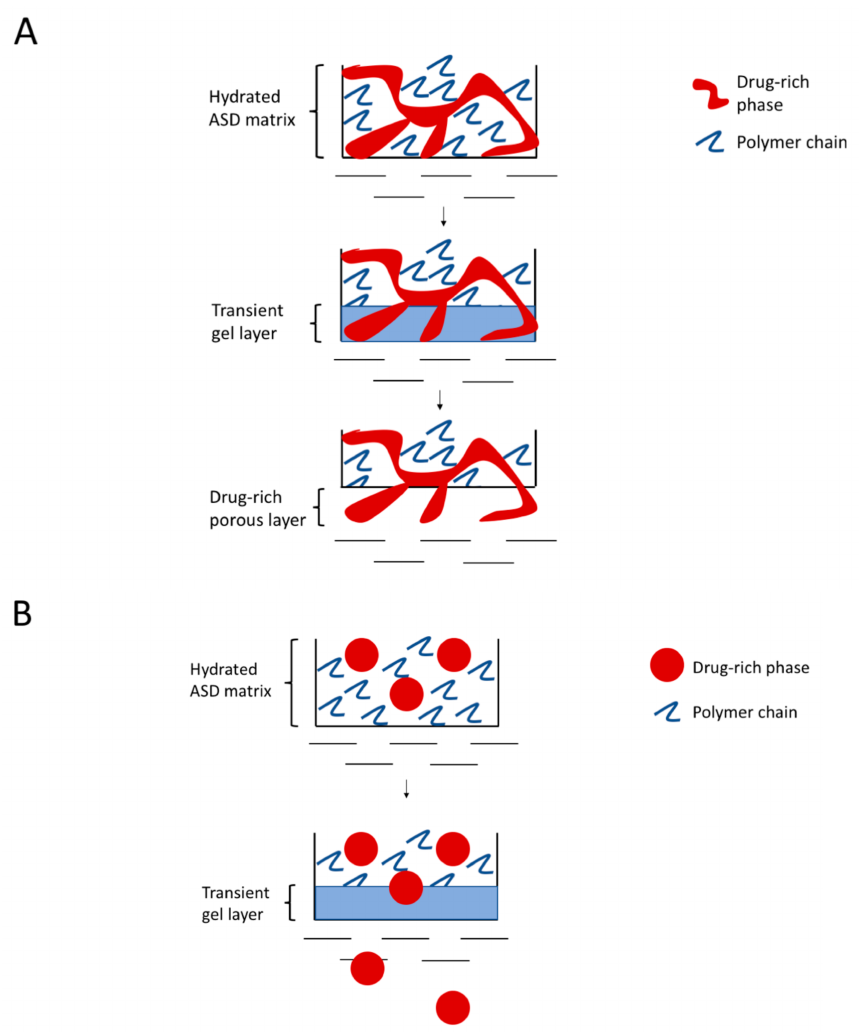
Figure 14. Schematic showing microstructure evolution and dissolution process of drug and poly- mer from high drug-loaded ASDs at lower and higher surfactant levels: ( A ) Phase behavior and dissolution process of 30% DL felodipine-PVPVA ASDs without TPGS and 2% TPGS, whereby phase separated drug-rich and polymer-rich phases release incongruently, leaving behind a porous drug-rich layer on the tablet surface and ( B ) Phase behavior and dissolution process of 30% DL felodipine-PVPVA ASDs with 5% and 10% TPGS, whereby drug-rich domains release intact as the polymer dissolves and the transient gel layer recedes, leading to the congruent release of drug and polymer (Adapted with permission from [48], Elsevier,